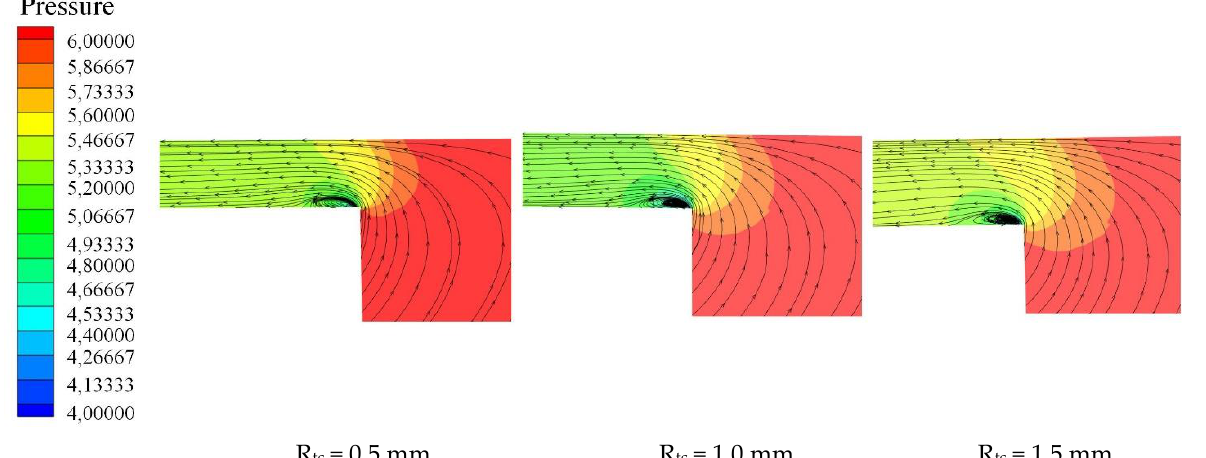
Figure 14. Observation region.